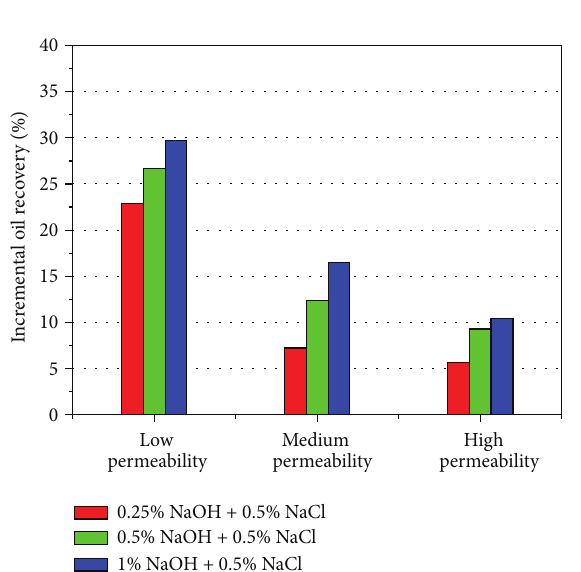
Figure 4: Alkaline flooding performance of Chenzhuang heavy